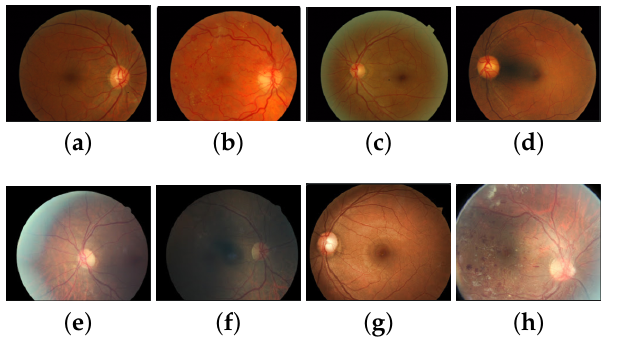
Figure 3. Key frames of Messidor-2 ( a – d ) dataset and EyePACS dataset ( e – h ) depicting their relative alignment and noise